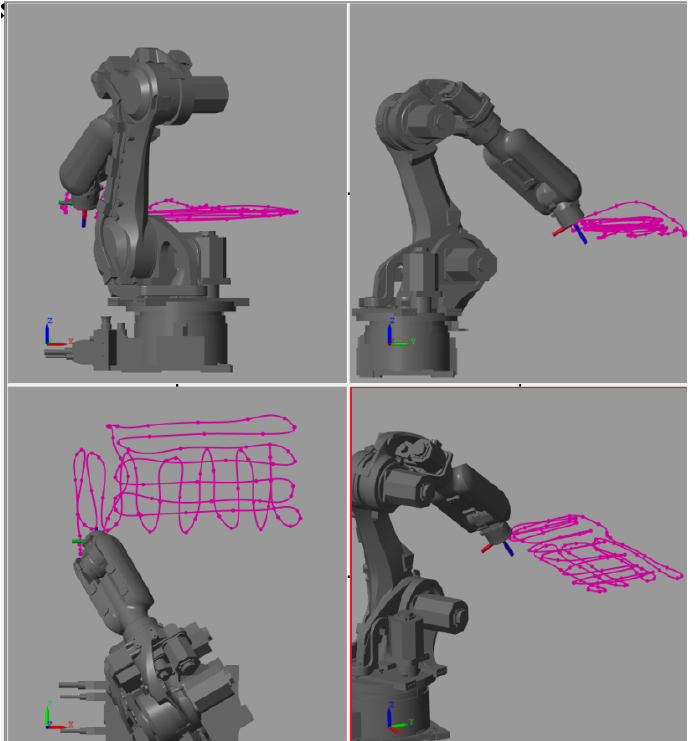
Figure 7. Robot motion simulation module—3D visualisation showing the resulting trajectory of the robot, allowing a final inspection of the computed motion